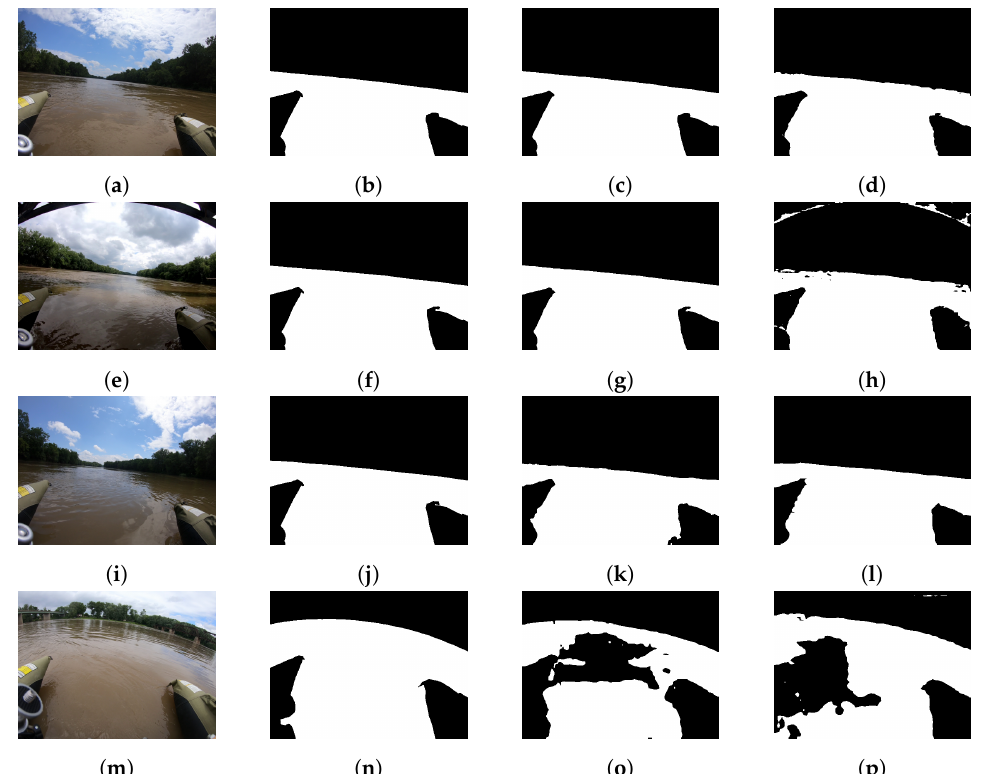
Figure 7. Illustration of network outputs on Wabash River scenes after further training on the ROSEBUD Sugar Creek image subset [38]. Images ( a – h ) are WaSR outputs after training 4 epochs on Sugar Creek images, and ( m – p ) are WODIS_Xcept network outputs after training an additional 20 epochs. Columns from left to right are the test image, the ground truth mask, the output of the network after initial training, and the output of the network after further training on the Sugar Creek